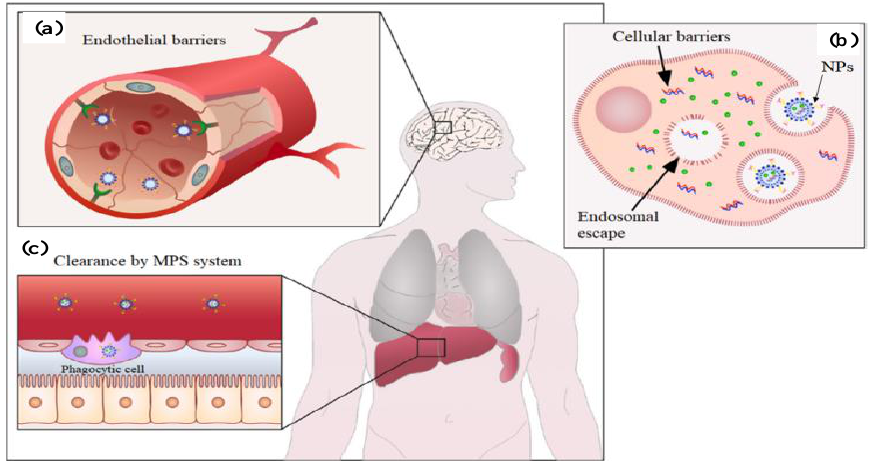
Figure 2. Main physiological barriers faced by nanoparticles (NPs). ( a ) Endothelial barriers, during the extravasation process into tumor tissues. ( b ) The endo-lysosomal compartment, during the absorption of NPs by target cells. ( c ) The clearance of NPs by phagocytic cells, especially the mononuclear phagocyte system (MPS) [21]. Reprinted with permission from ref. [21]. Copyright 2018 Springer Nature.